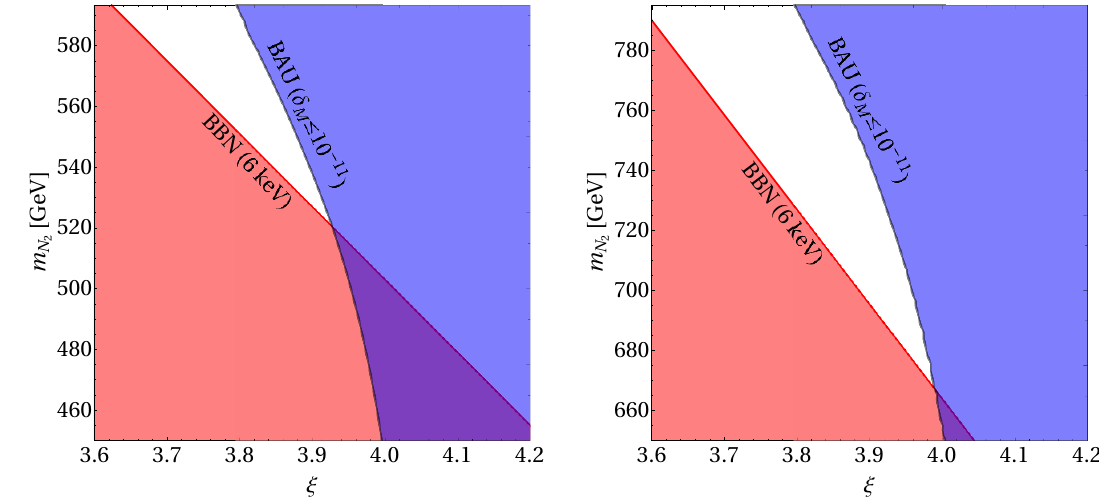
Figure 9. Allowed region in the ( (cid:24); m N ) parameter space for (cid:12)xed (cid:22) 2 = 600 GeV (left) and (cid:22) 2 = 2 800 GeV (right). The BBN exclusion limits are shown in red, while the blue shaded region does